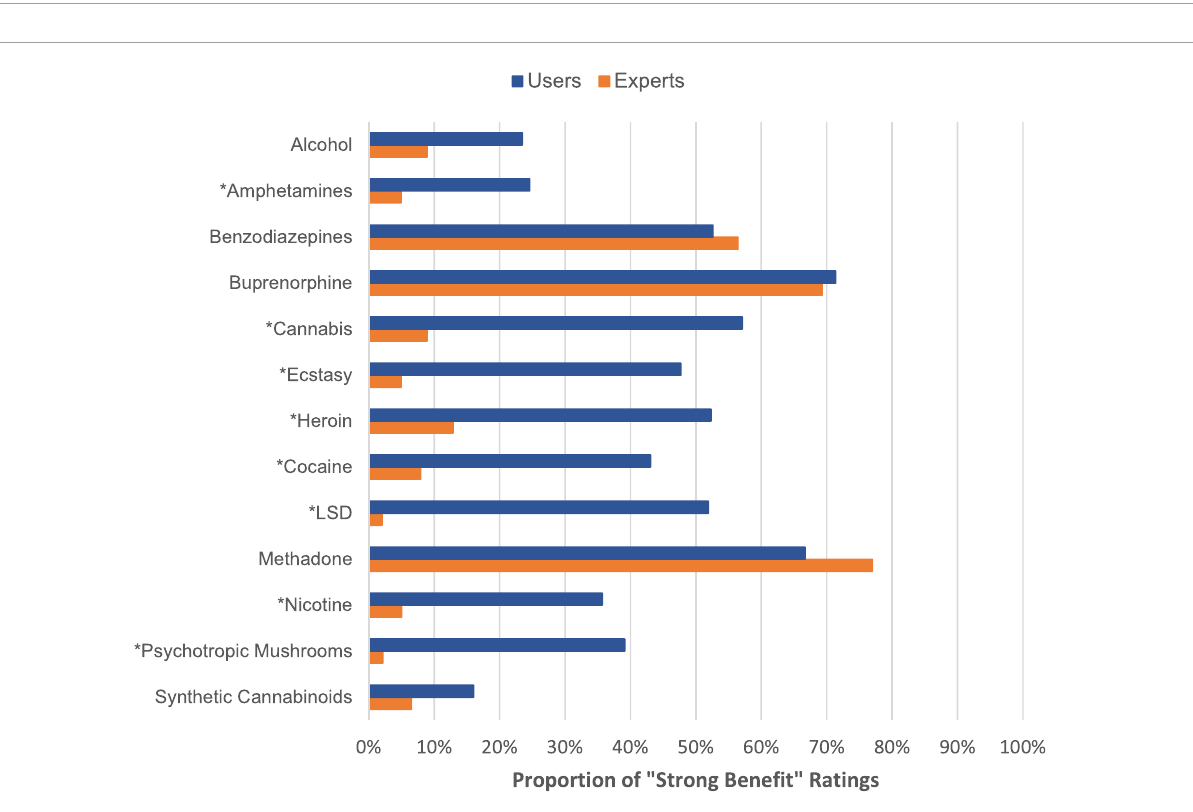
FIGURE8 Proportion of “strong benefit” ratings made by users versus experts. * p < 0.01. Supplementary Figure 23 shows also the ratings for the excluded